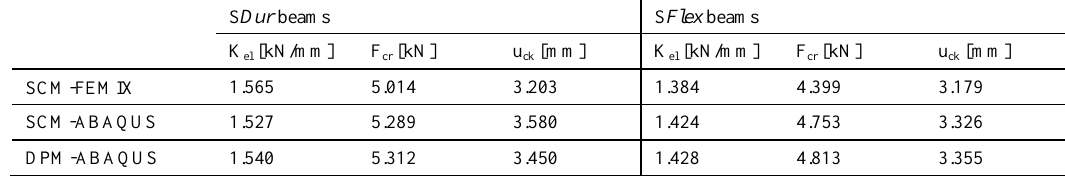
Fig. 6 Load vs . displacement diagrams of S Dur (left side) and S Flex (right side) beams obtained with the distinct models. Table 2: Elastic properties of the S Dur and S Flex beams defined from the responses obtained in different